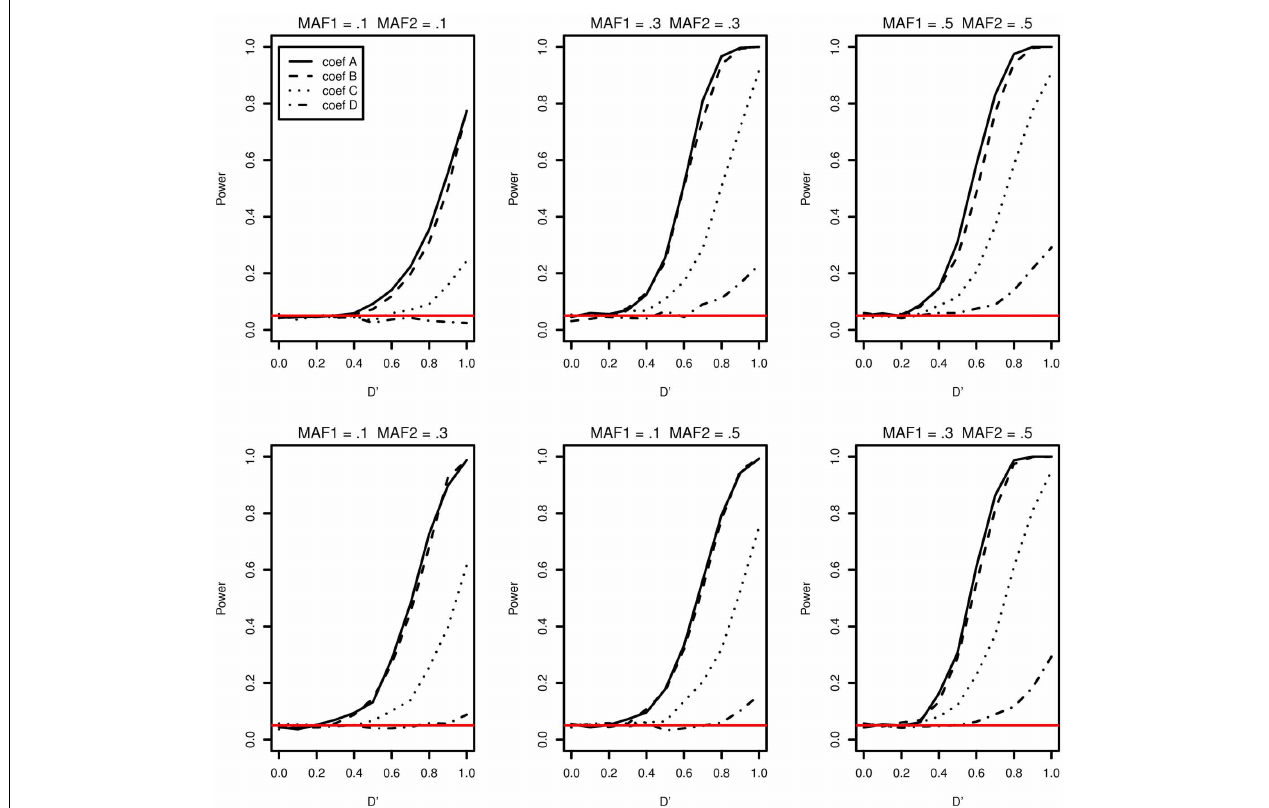
and β 12 = 0 . 75, coef C : β 1 = 0 . 5, β 2 = 0 . 5, and β 12 = 0 . 5, coef D : β 1 = 0 . 75, = 0 . 5 and σ 2 = 1, and the sample size is β 2 = 0 . 75, and β 12 = 0 . 25, and σ 2 a e 2000 (1000 families). The red horizontal line indicates the 0.05 significance level.